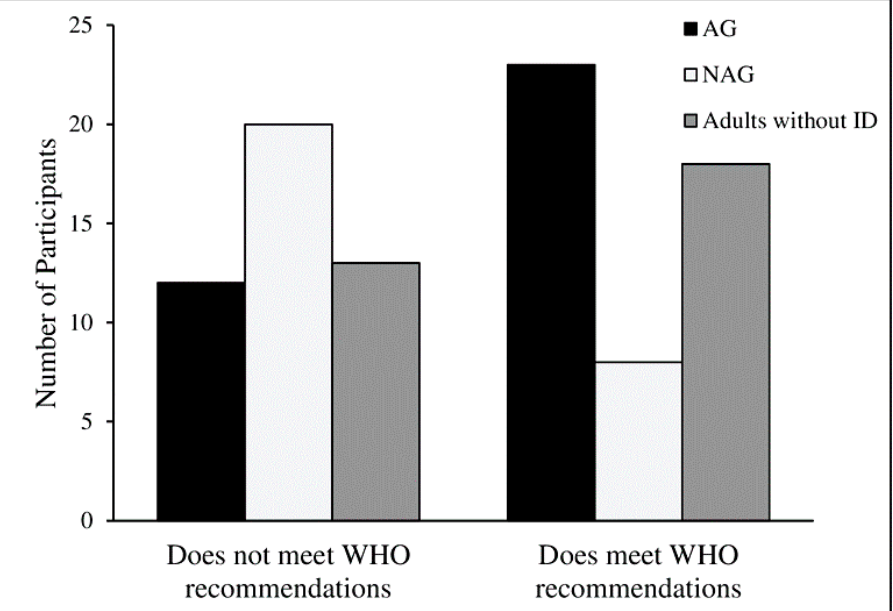
Figure 4. Total number of participants meeting or not meeting the World Health Organization (WHO) global recommendations on PA for health ( X 2 = 9.25; p = 0.010).